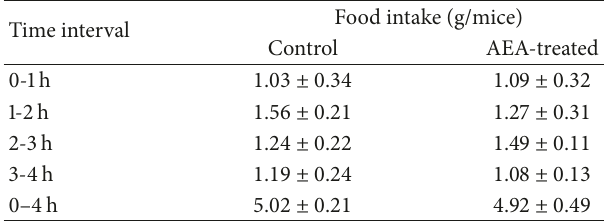
Figure 1: Food intake of control and AEA-treated animals during 10-day intervals (21–150 days old; mean ± SEM; 𝑛 = 8 cages/group). Table 1: Food intake during the first 4 hours after a dose of AEA in adult